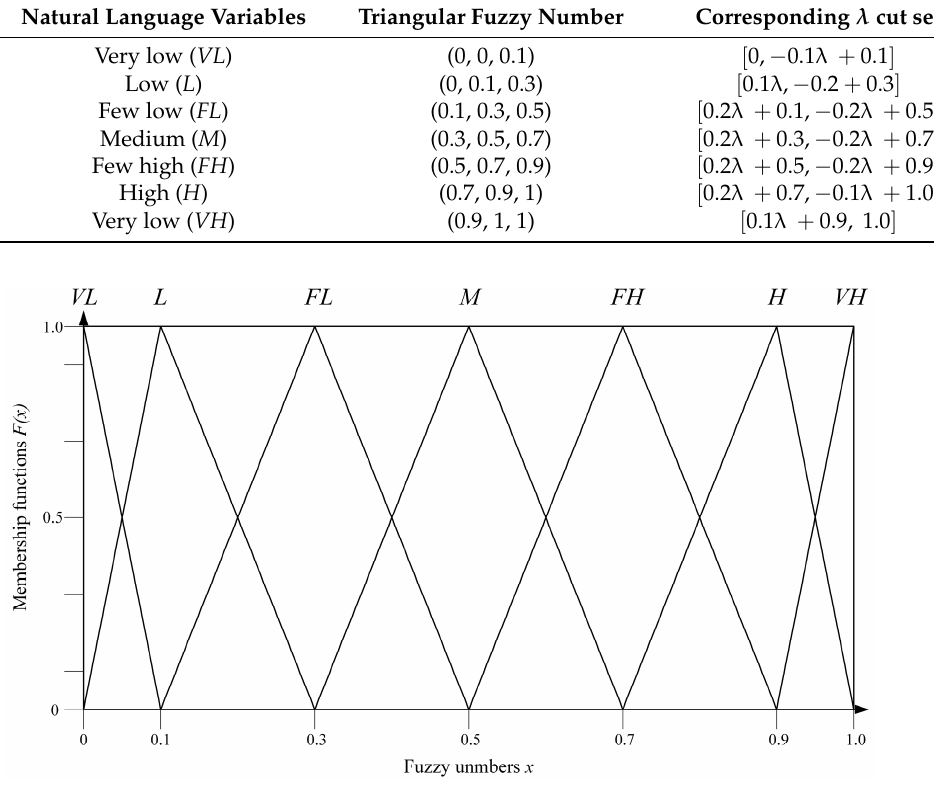
Figure 2. Membership functions of natural language variables of grade 7 and triangular fuzzy num- ber.